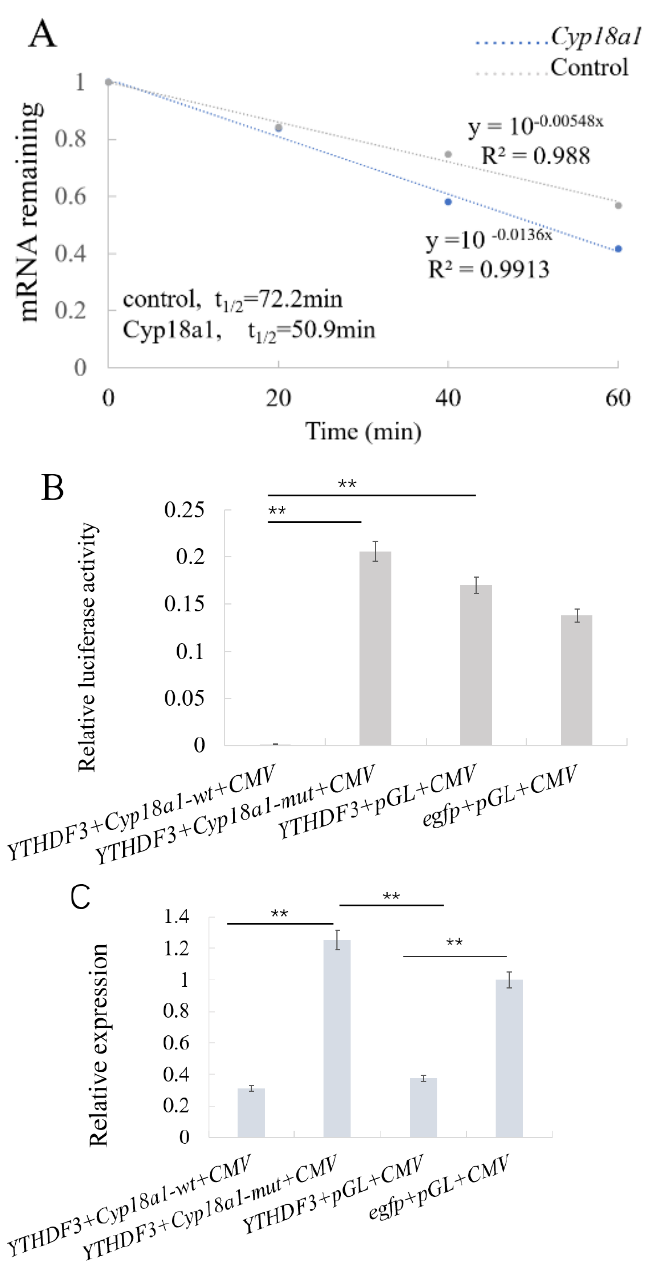
Figure 4. YTHDF3 mediates Cyp18a1 mRNA degradation in the ecdysone pathway. ( A ) Reducing the Cyp18a1 mRNA half − life by overexpressing YTHDF3 in BmN cells. ( B ) Relative firefly luciferase activity. ( C ) mRNA level of Cyp18a1 . Values are mean ± s.d. of n = 4 independent experiments. Two −tailed Student’s t− tests were used (** p < 0.01).